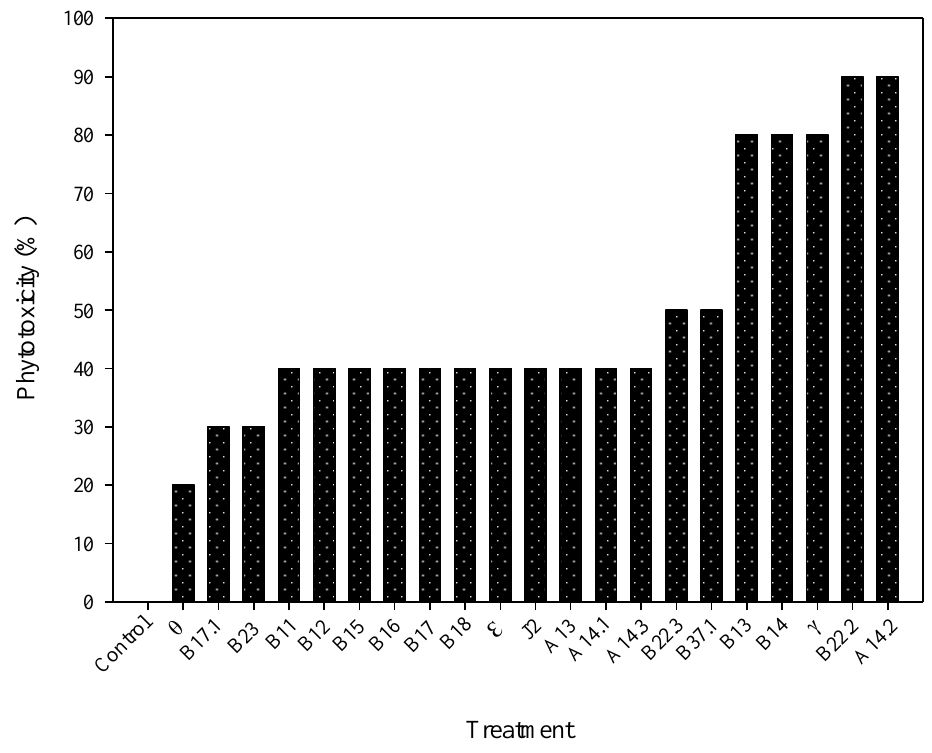
Figure 1. Phytotoxicity (%) of supernatants at 21 days after application (DAA) in C. sativus . Five microorganisms presented significant results concerning phytotoxicity: strain B22.2, strain γ , strain A14.2, strain B13, and strain B14, as they presented mortality of at least one of the plants in the stand, and phytotoxicity equal to or higher than 80%. The other microorganisms showed less intense effects and plant recovery throughout the trial evaluation